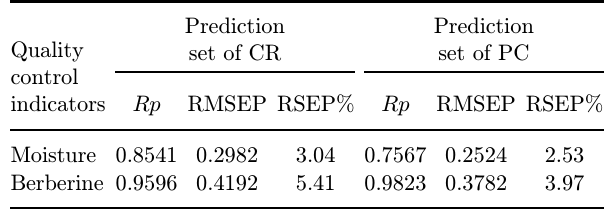
Table 5. Prediction results of CARS-PLS global models. Quality